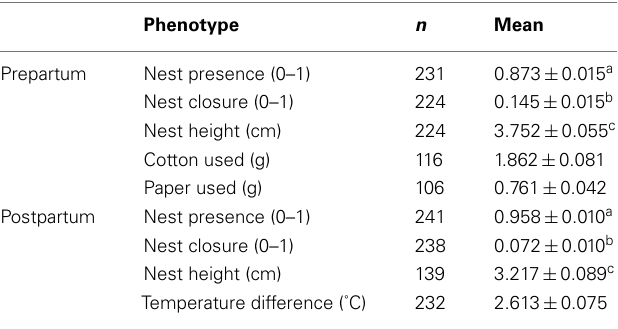
Table 1 | Nest building for pre- and postpartum periods, in F 2 females in maternal